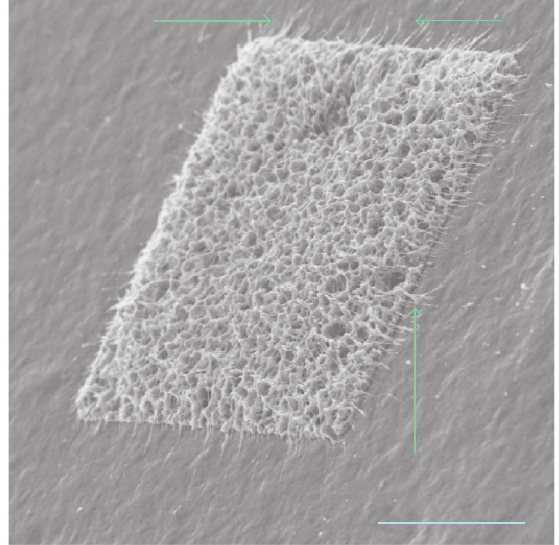
Figure 12: SEM image of collagen/PVP film surface after laser irra- diation ( F = 1 . 7 J/cm 2 , 1 pulse, scale bar is 50 μ m). Green arrows show filaments at the edges of irradiated